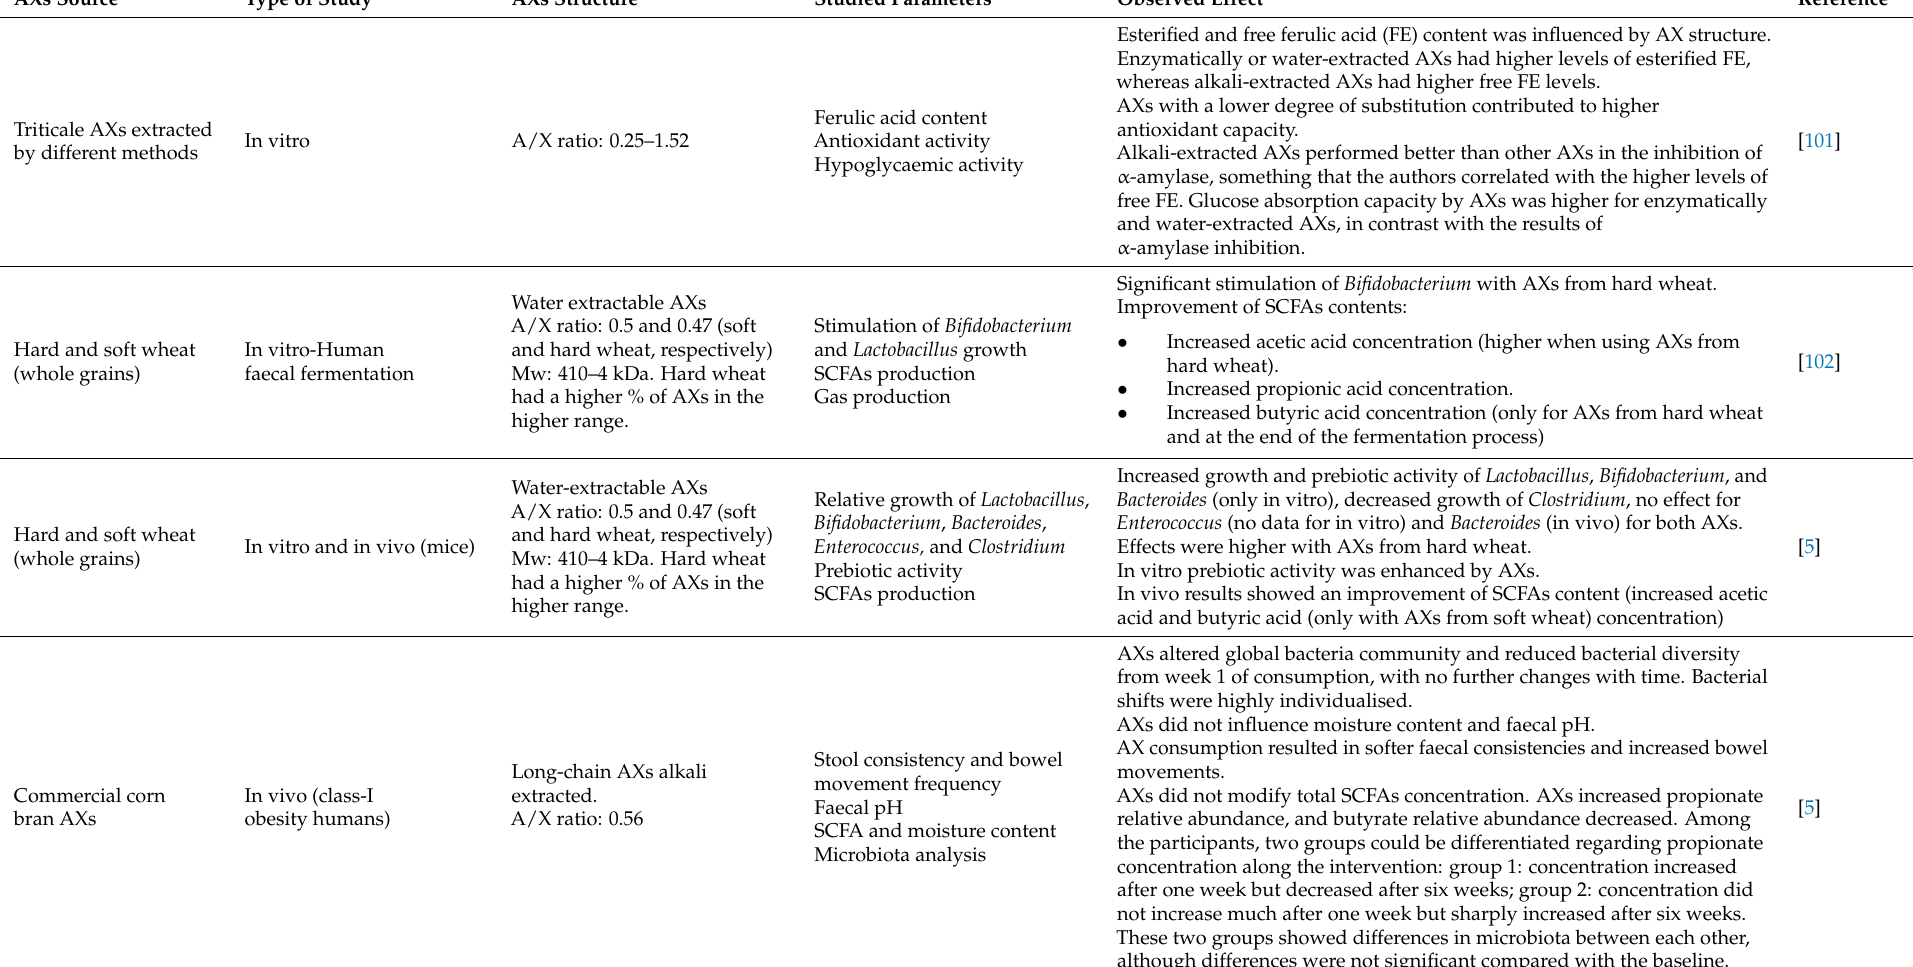
Table 3. Most recent and relevant studies on the effects of arabinoxylans on the gut